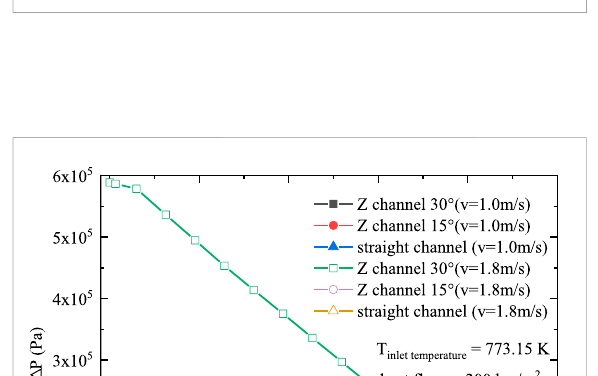
FIGURE 12 Variation in the pressure drop along the circular tube for different diameter channels at different velocities.